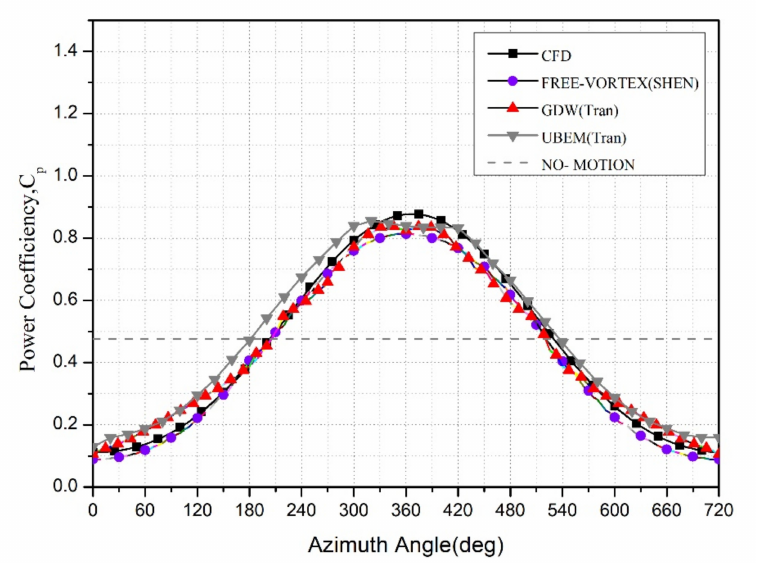
Figure 7. Power coefficient variation with the pitch motion at A = 4 ◦ and f = 0.1